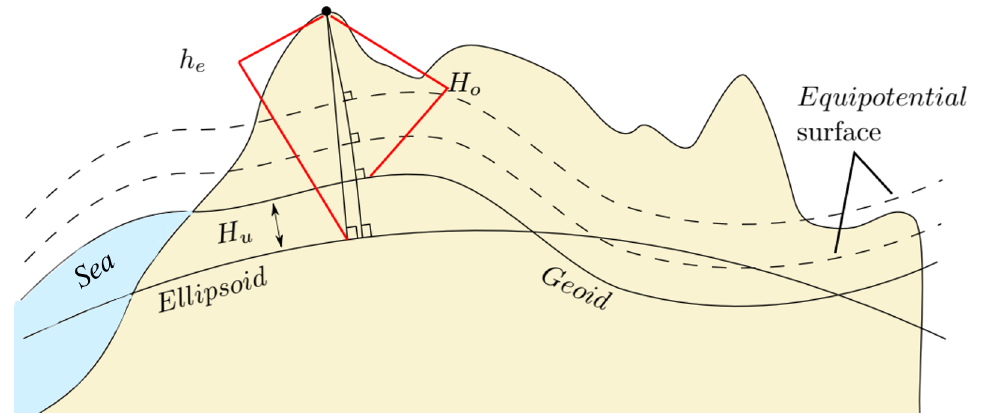
Figure 2. Different vertical data (geoid or ellipsoid) are possible depending on the selected ap- proximation for the earth’s surface. The corresponding heights for the respective vertical data are ellipsoidal height ( h e ), and orthometric height ( H o ). These two height systems are related by the geoid height H u .